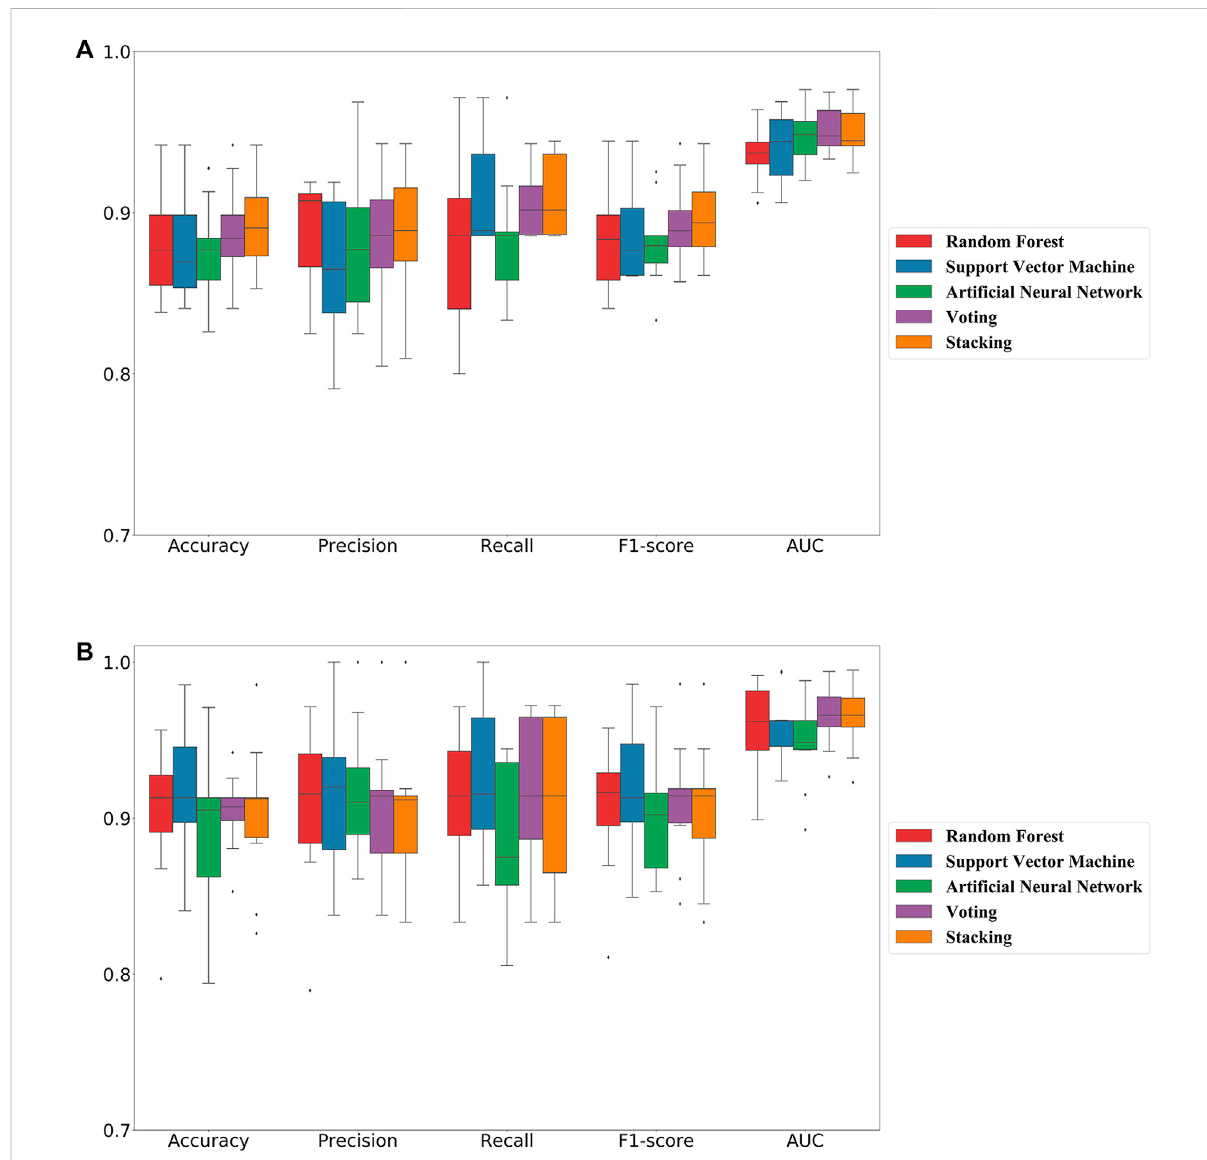
FIGURE 2 10-fold cross-validation results of fi ve machine learning classi fi cation models on the training set. (A) Models constructed based on molecular fi ngerprint; (B) Models constructed based on molecular